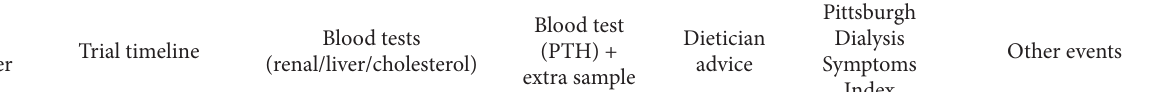
Table 2: HRG—treatment for each study